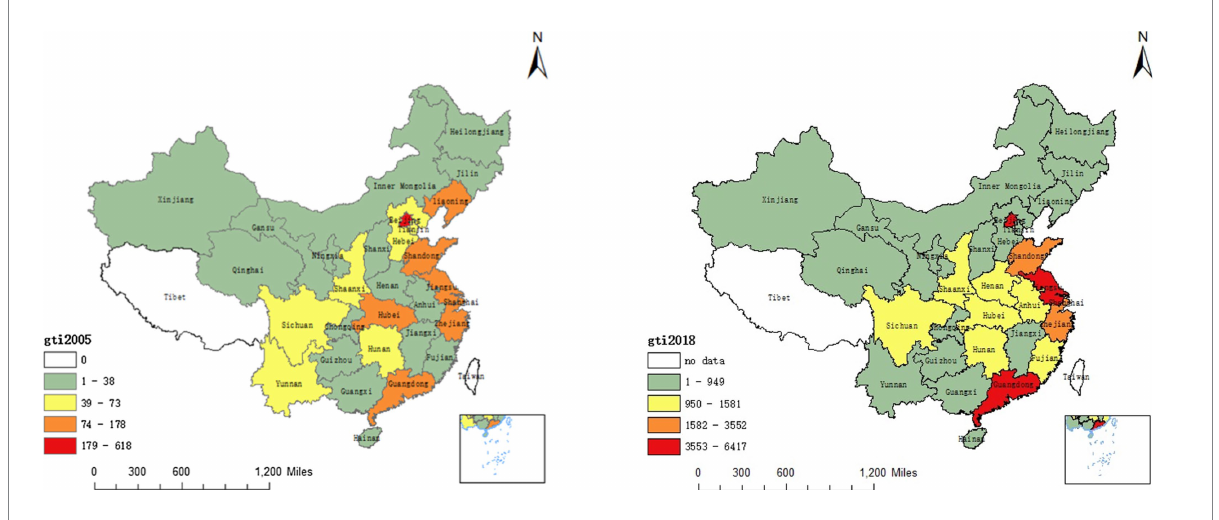
FIGURE 1 China’s green technology innovation in the year 2005 and